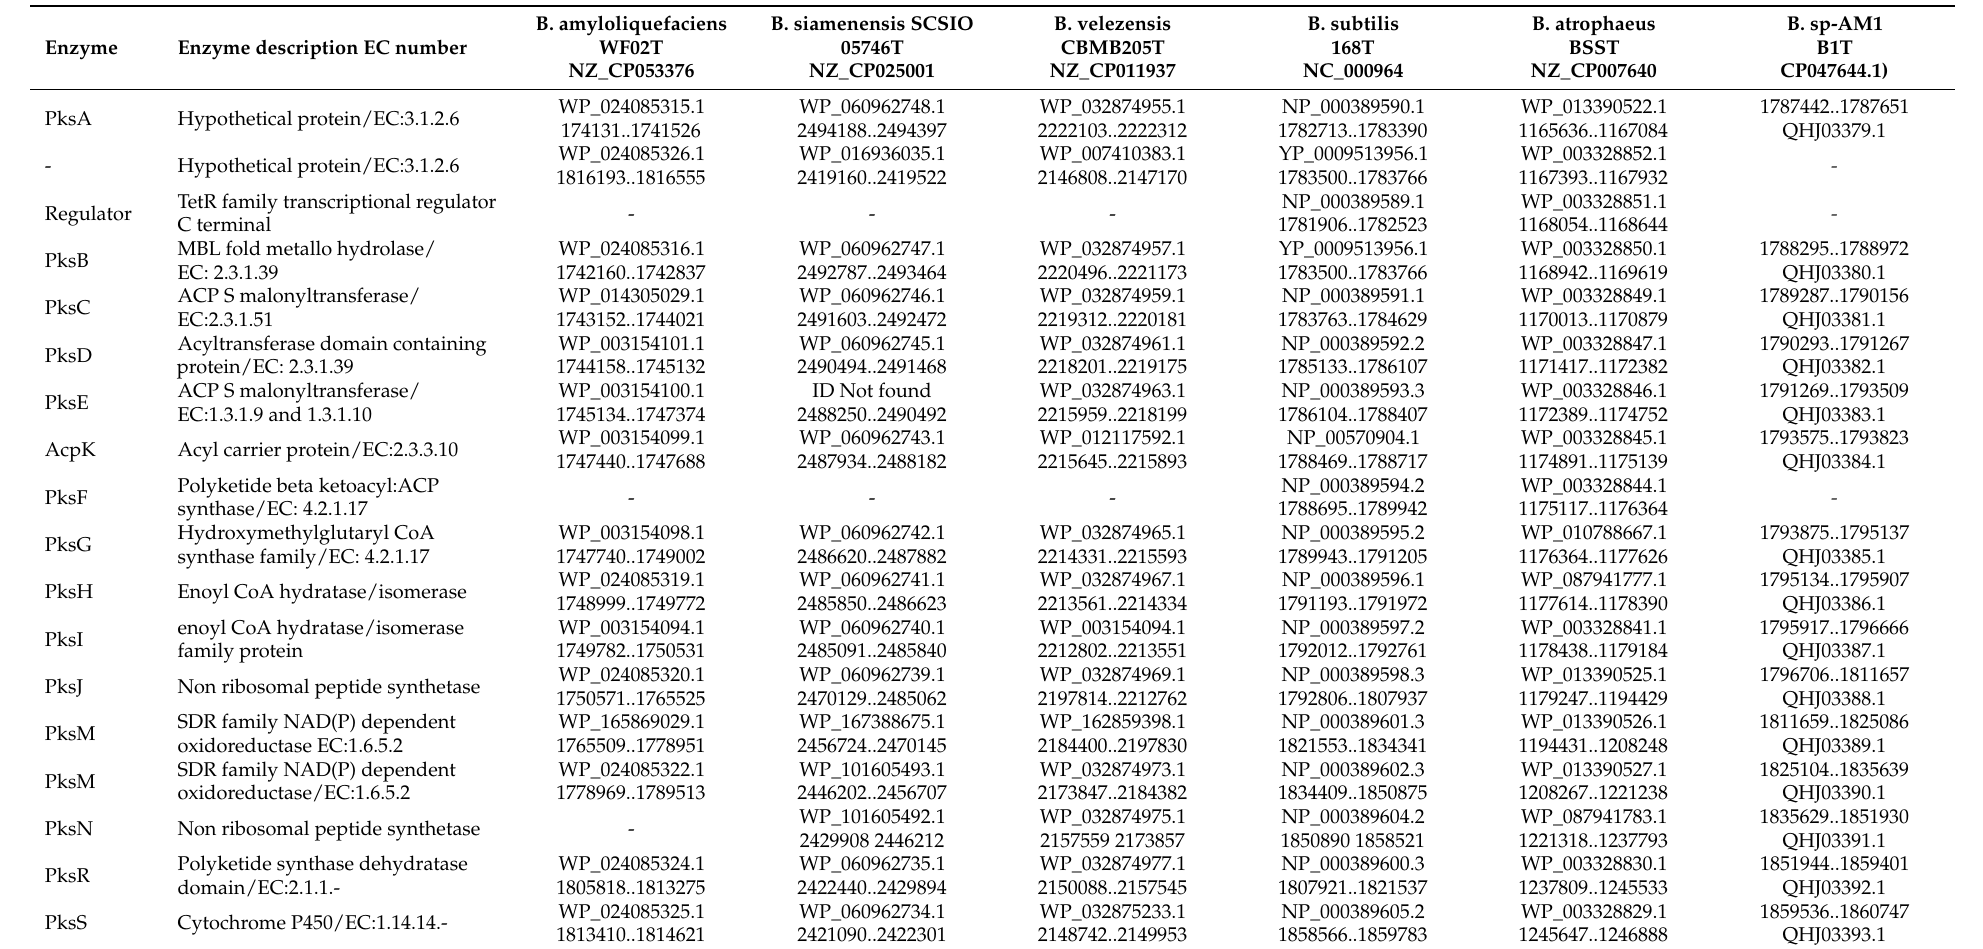
Table 5. Gene-encoding and corresponding enzymes involved in Polyketide biosynthesis in WGS of Type strain of Bacillus spp